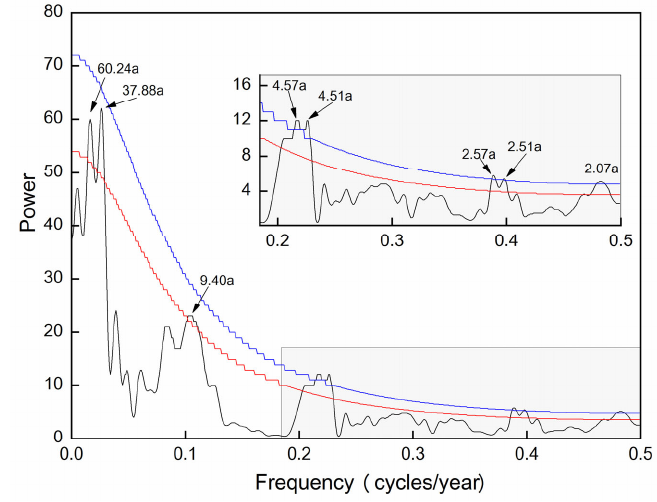
Figure 7. Results of the MTM spectral density of the reconstruction. The red (blue) line is 95% (99%) confidence level.